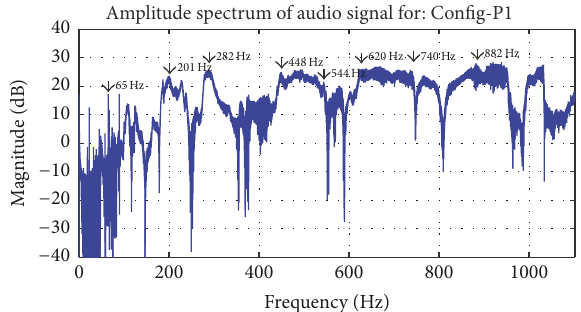
Figure 21: Spectral analysis showing modal frequencies excited for the LSRA at P1.